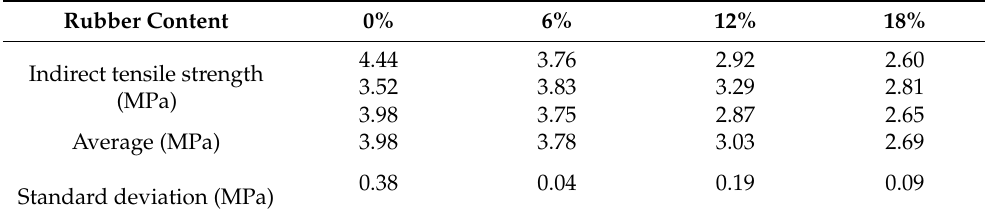
Figure 19. Failure modes of CRM12 specimens. Table 8. Test results of indirect tensile